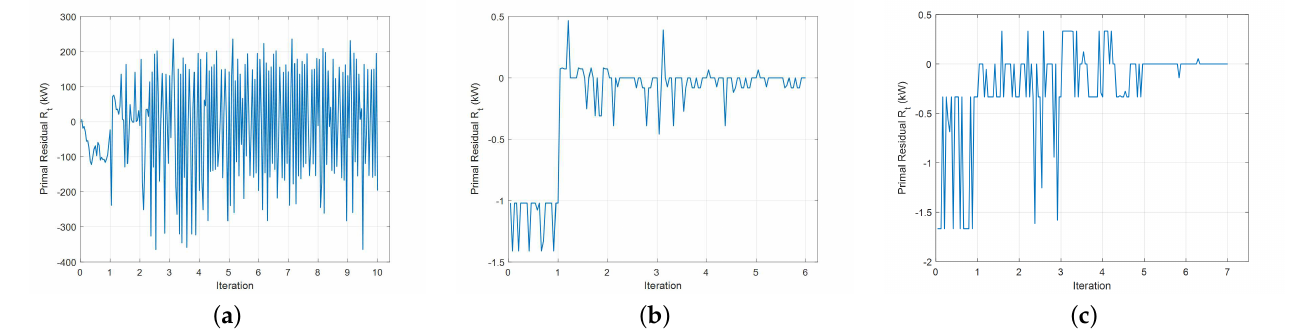
Figure 6. The generation–load mismatch R t of different methods in islanded mode. ( a ) Square of 1-norm. ( b ) Square of 2-norm. ( c ) Linearized square of